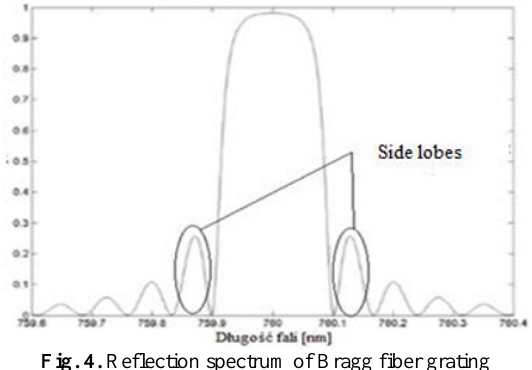
Fig. 4. Reflection spectrum of Bragg fiber